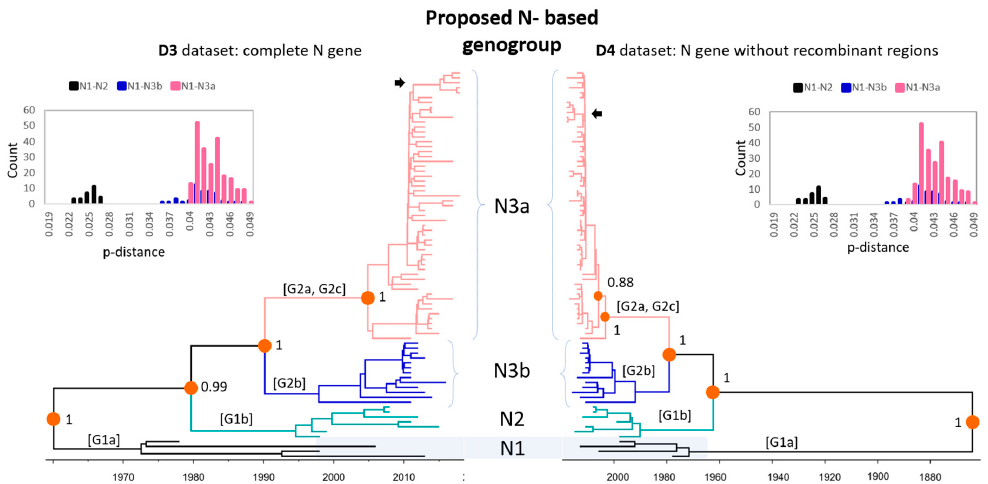
Figure 3. The time-scale maximum clade credibility phylogeny of global PEDV strains based on the nucleocapsid (N) gene. The phylogenetic trees were constructed based on the N gene without removing the recombinant regions (D3) and with the recombinant regions removed (D4). The spike (S) gene-based sub-genogroups were designated as G1a, G1b, G2a, G2b, and G2c. Each sub-genogroup was colored consistently with the D1–D4 datasets. The inserted panels are histograms of pairwise p -distances between geno-, sub-genogroups N1–N2 and N1–N3a/N3b. The Korean strains identified in this study are marked by arrows.